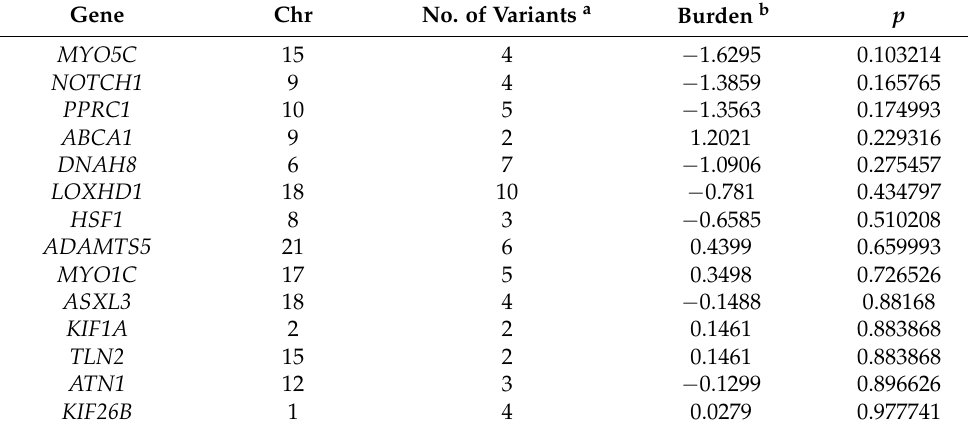
Table 1. Gene based burden test analysis of the multiplex